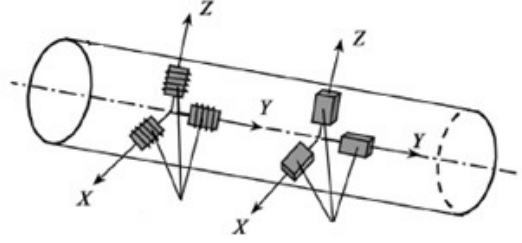
Figure 3. Schematic diagram of multi-sensor combination